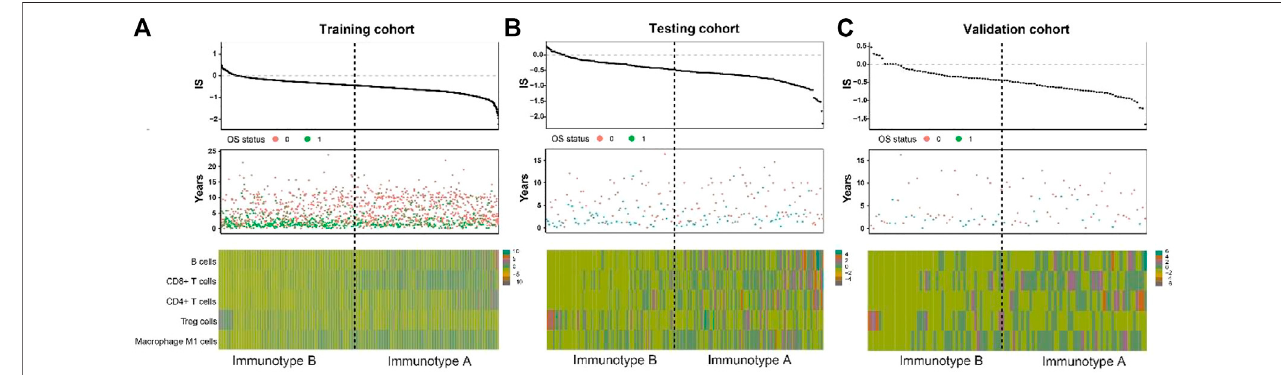
FIGURE 3 | Correlate immunotype with overall survival in training cohort, testing cohort and validation cohort. Hierarchical tree structure classifying the patients of the training cohort (A) the patients of the testing cohort. (B) and the patients of the validation cohort. (C) according to the levels of fi ve immune cell cluster features: high expression (green) and low expression (brown). OS status showed 0: survival; 1: death.